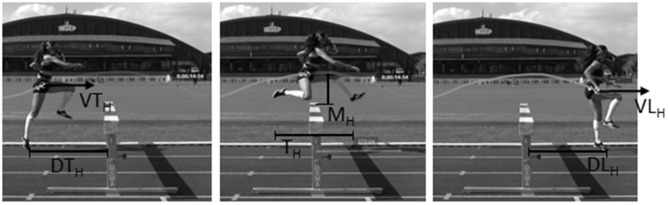
Mechanical parameters recorded during the hurdle clearing. Take-off (DTH) and landing distances (DLH) around the hurdle, maximal height over the hurdle (MH), time to clear the hurdle (TH) and take-off (VTH) and landing velocities (VLH) around the hurdle.